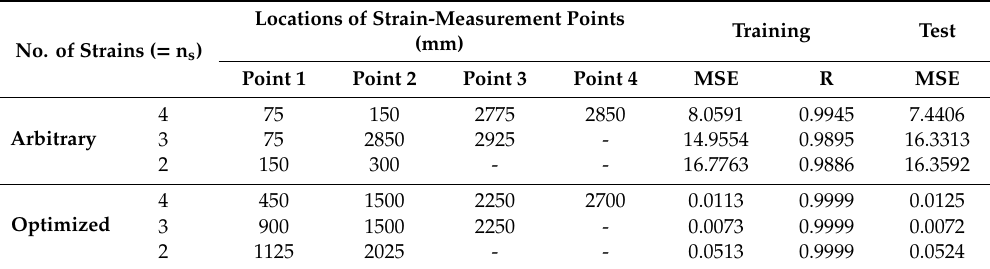
Table 3. The results of ANN training and testing with optimized strain-measurement points.